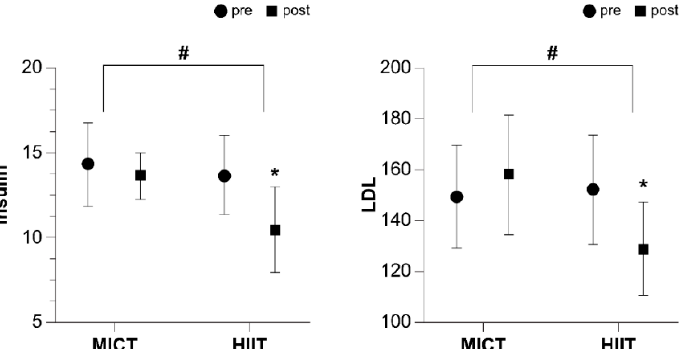
Figure 2. Effect on blood glucose and lipid profile according to exercise intensity. MICT: moderate- intensity continuous training, HIIT: high-intensity interval training, LDL: low-density lipoprotein. Bars represent mean ± SD (MICT: n = 8, HIIT: n = 8). * p < 0.05 from Pre to Post. # p < 0.05 change (post-pre) between groups.